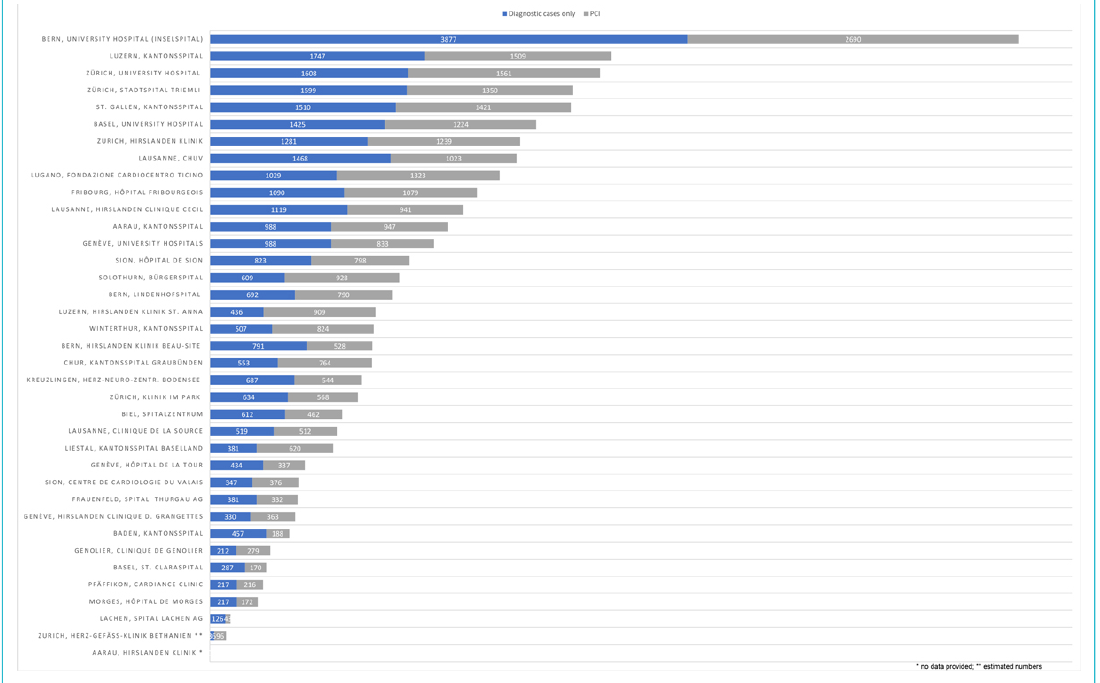
Figure 2: Coronary angiographies and interventions in Switzerland 2019 – centres ranked by total number of